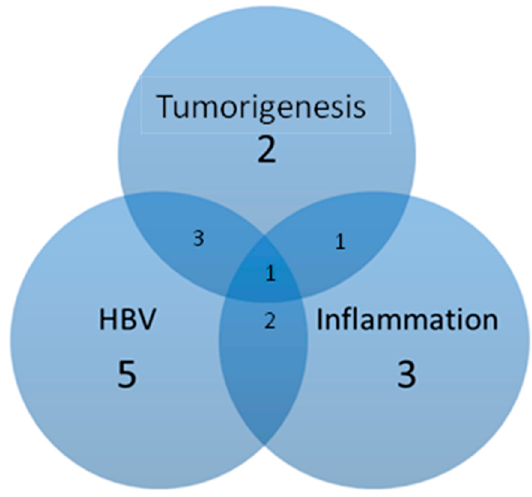
Figure 4. The MASCOT results indicate that 11 proteins were associated with HBV, 7 proteins were associated with inflammation, and 7 proteins were associated with tumorigenesis. Among these proteins, Cathepsin B (CTSB) and Follistatin-related protein 1 (FSTL1) were involved in tumorgenesis, but not HBV nor inflammation. Transforming growth factor-beta receptor-associated protein 1 (TGF- β ) was the only protein associated with tumor, inflammation, and HBV.